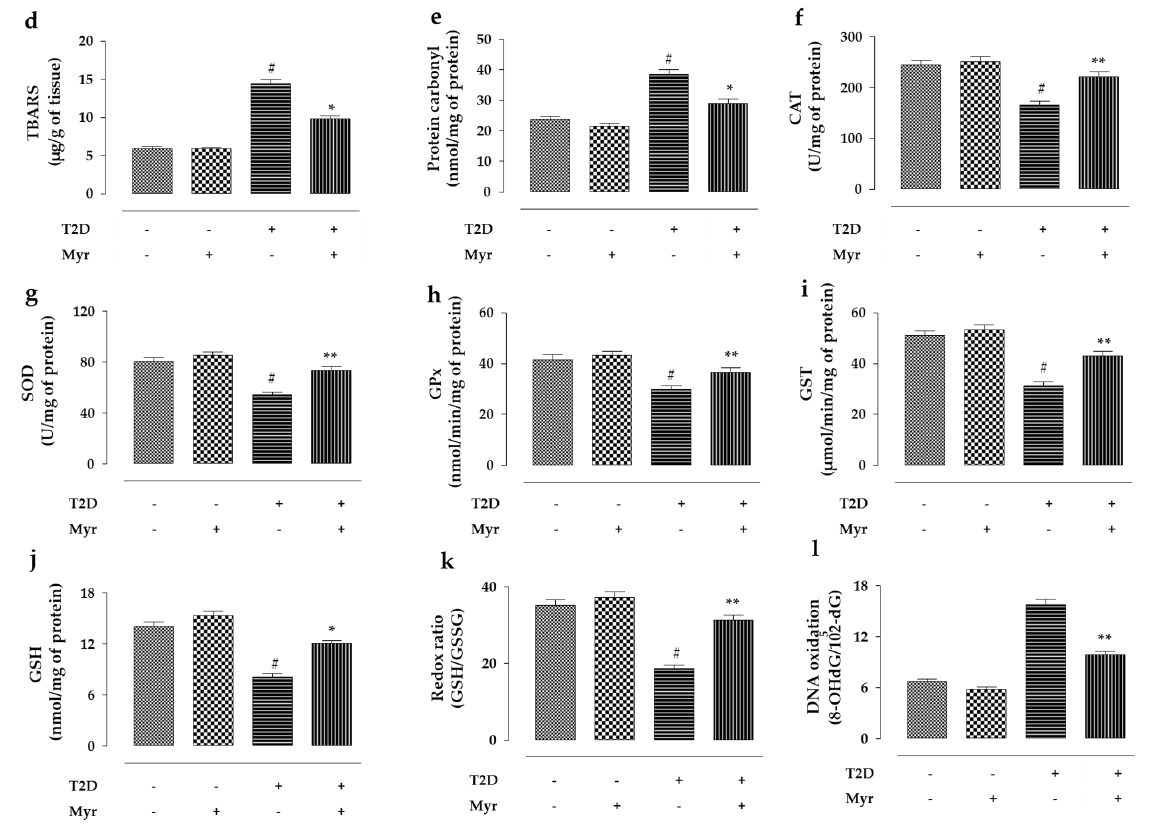
Figure 10. The effects of Myr on redox imbalance in the kidneys of T2D rats. The graphs showing the effect on intracellular ROS ( a ), NADPH oxidase ( b ), NO ( c ), TBARS ( d ), protein carbonyl ( e ), CAT ( f ), SOD ( g ), GPx ( h ), GST ( i ), GSH ( j ), redox ratio ( k ), and DNA oxidation ( l ). Myr was effective in reducing T2D-induced increase in the levels of intracellular ROS, NADPH oxidase, NO, lipid peroxidation, protein carbonylation, and DNA oxidation, while it increased CAT, SOD, GPx, GST, GSH, and redox ration. Data are expressed as mean ± SD ( n = 6). # Values significantly ( p < 0.01) differed from the normal control (T2D − ) group. * Values significantly ( p < 0.05) differed from the diabetic control (T2D+) group. ** Values significantly ( p < 0.01) differed from the diabetic control (T2D+) group. SOD unit, “U”, is defined as inhibition (µ-moles) of nitro blue tetrazolium (NBT)-reduction/min. CAT unit, “U”, is defined as H 2 O 2 consumption/min.